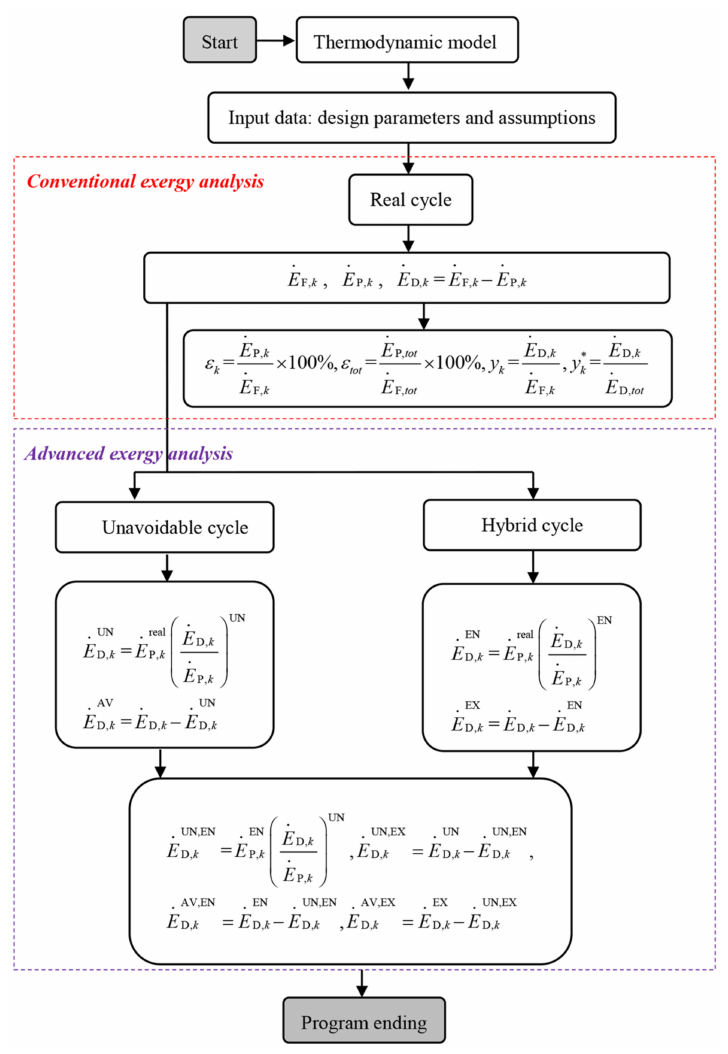
Figure 2. The flow chart of the calculation procedure. Table 3. Values at real, unavoidable and ideal cycles